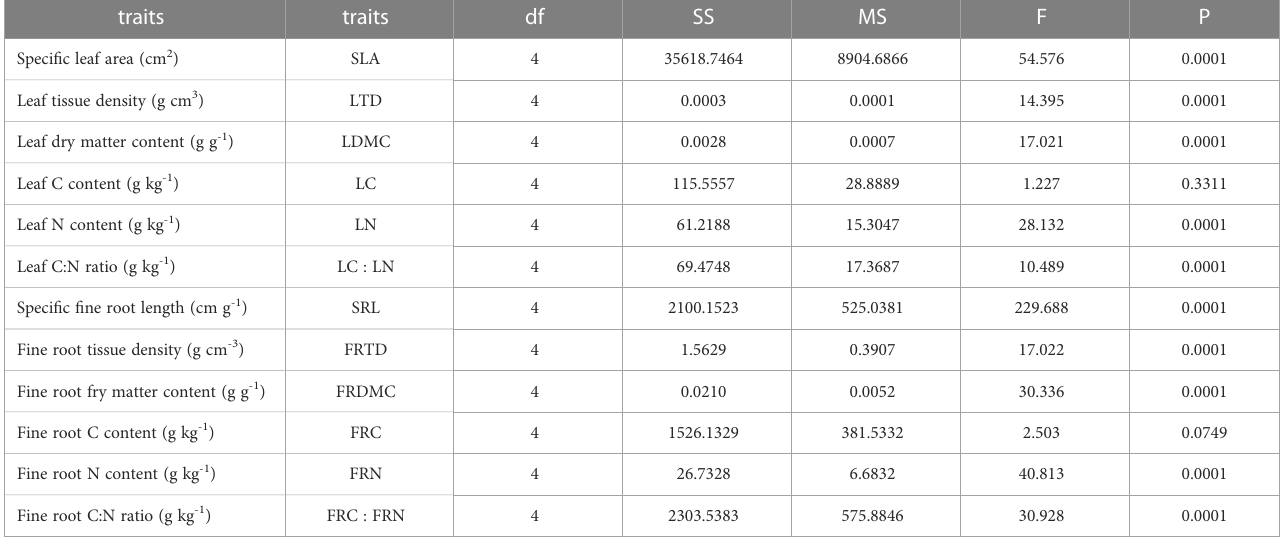
TABLE 2 Analysis of variance of leaf and fi ne root functional traits. traits traits